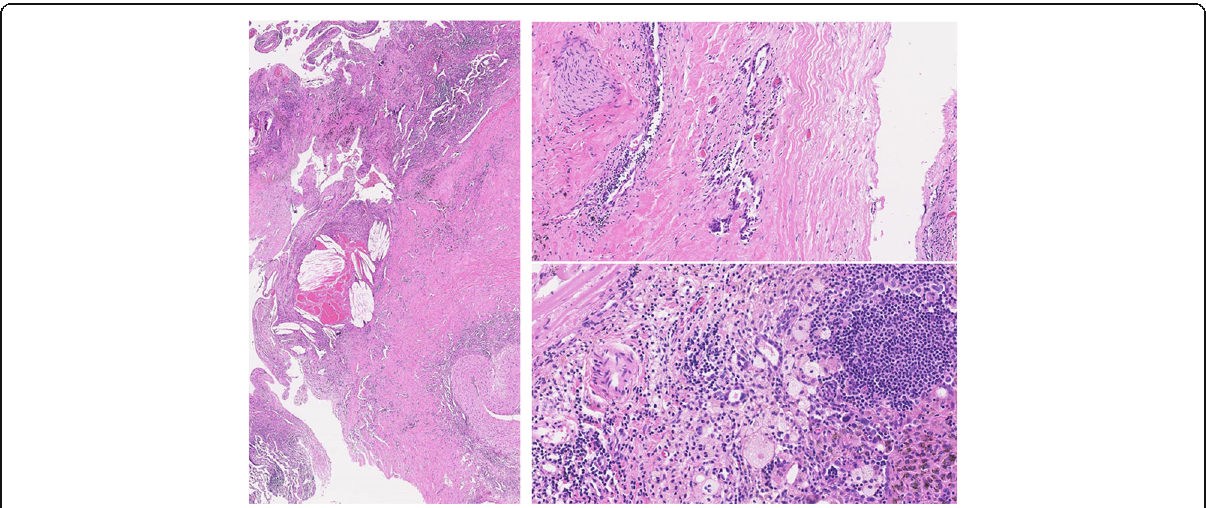
Fig. 3 Histological findings after the treatment with alectinib. (Left) No viable tumor cells are seen in most pathological sections cut from the primary tumor and lymph nodes. (Right) Only a small number of atypical cells were seen in some primary tumor sections (upper) and nodal sections